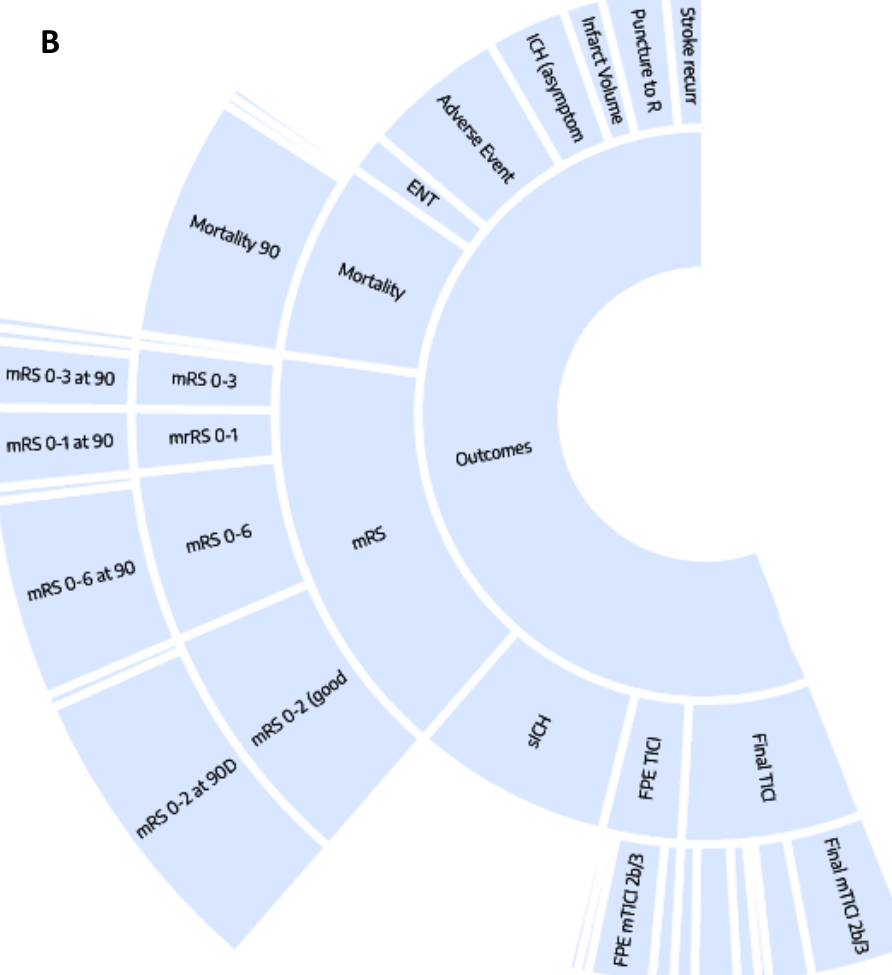
Figure 3. ( A ) Distribution of reported outcomes among different studies. mRS: the modified Rankin Scale; ICH: intracerebral hemorrhage; TICI: the Thrombolysis in Cerebral Infarction scale; FPE: first-pass effect; ENT: emboli to new territories. ( B ) Heterogeneity in the reported outcomes.